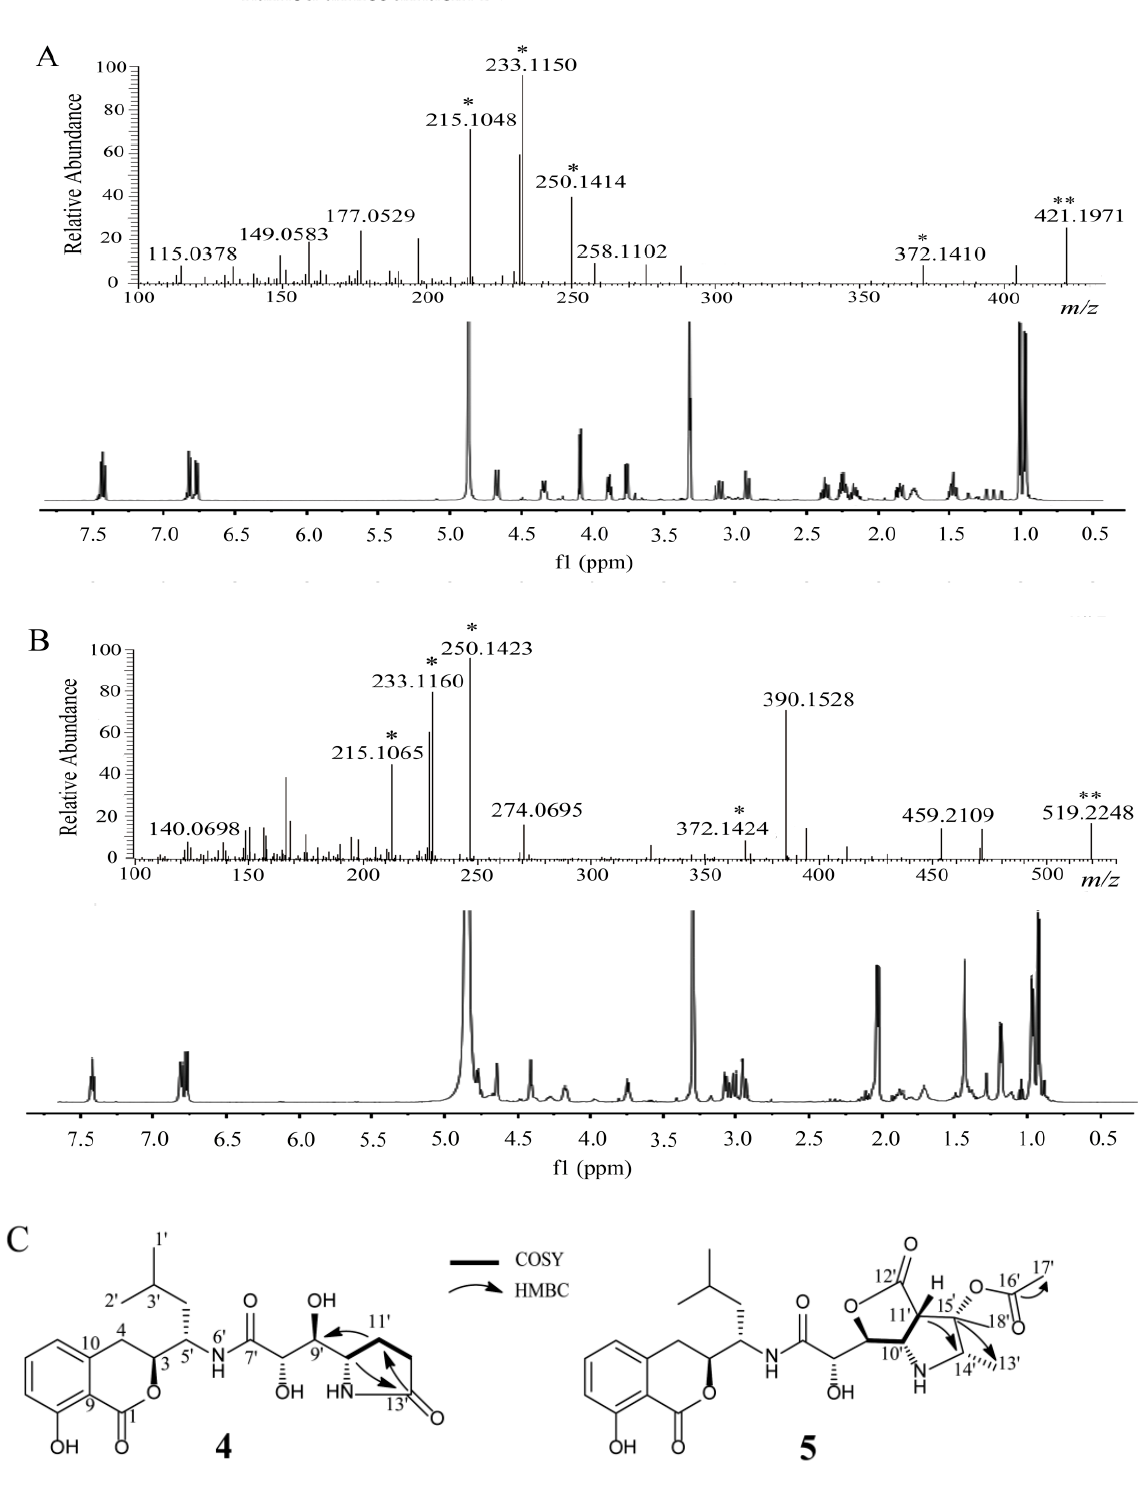
Figure 2. ( A ) HRMS/MS and 1 H NMR analysis of amicoumacin D, 4 ( B ) HRMS/MS and ( B ) 1 H NMR analysis of ami- coumacin E, 5 . ( C ) Key 1 H– 1 H COSY, HMBC, relative stereochemistry of amicoumacin D, 4 , E, 5 . * Characteristic ion peak. ** Precursor ion